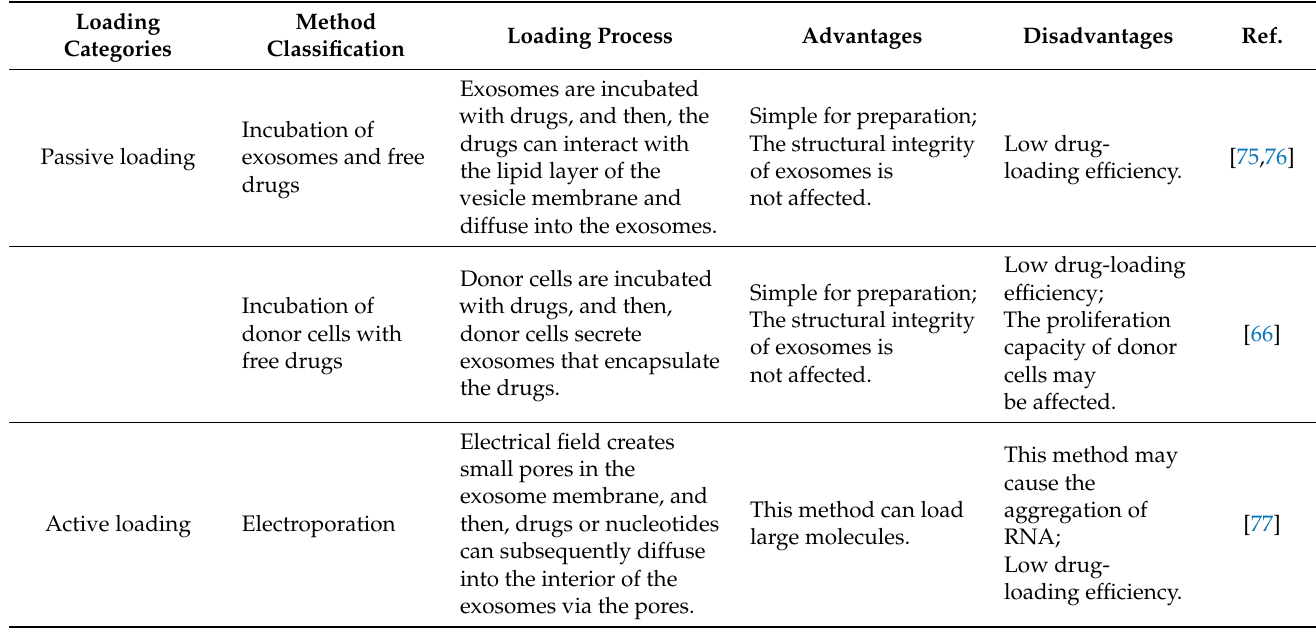
Table 3. Comparison of different methods for loading therapeutic agents into exosomes or exosome mimetics.